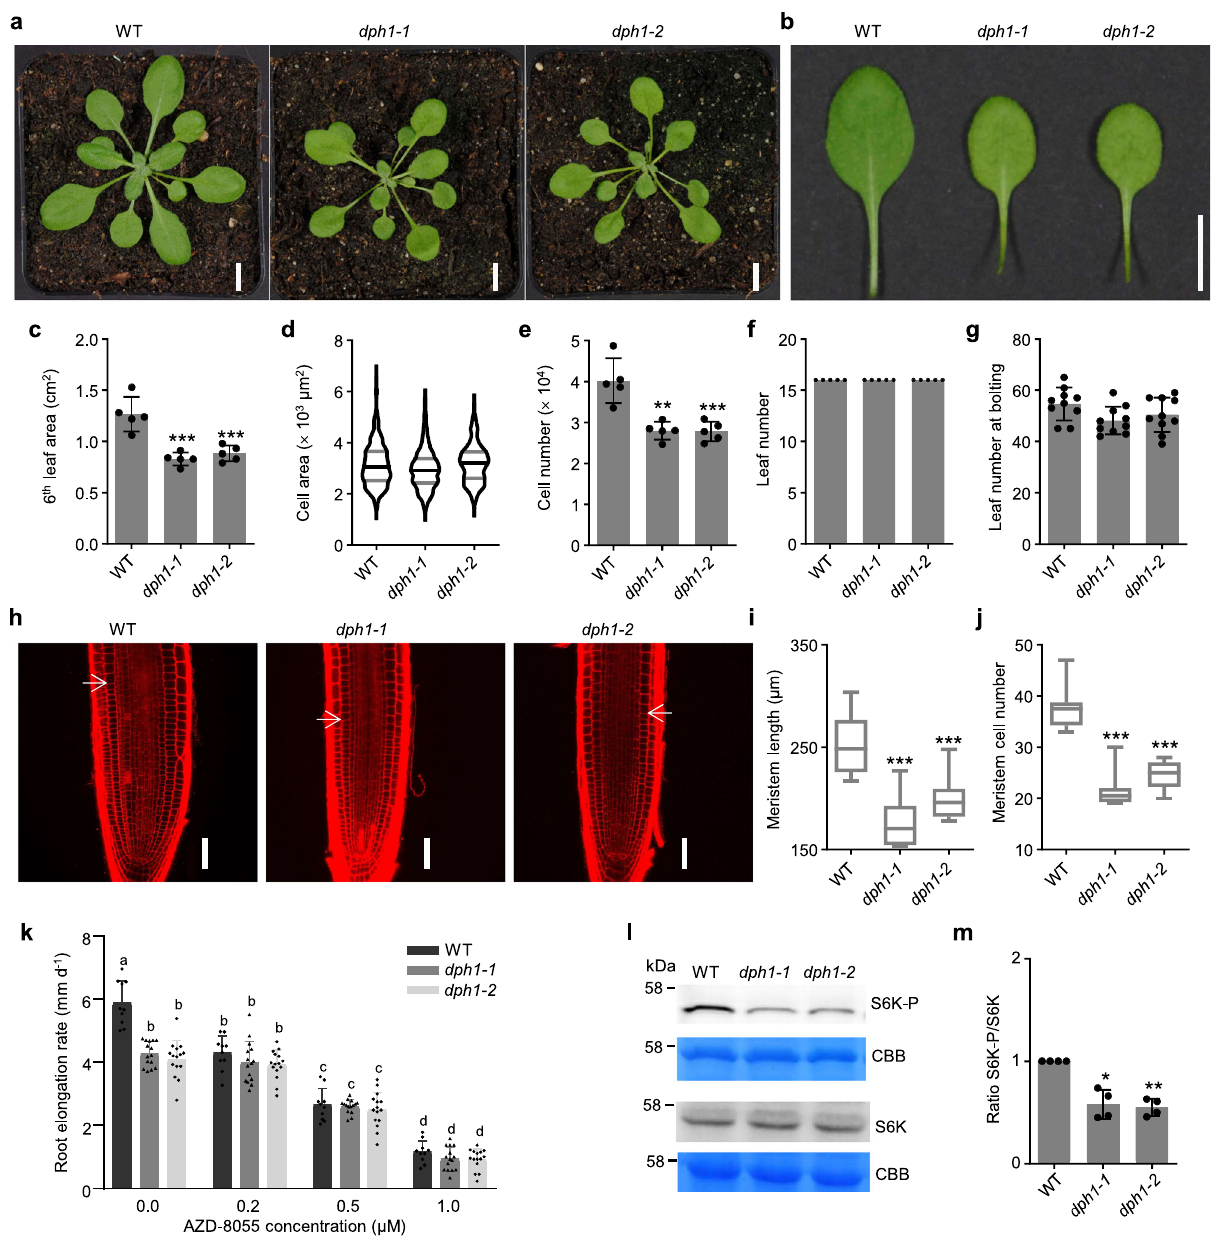
Fig. 3 Decreased organ size, cell number, and TOR activity in dph1 mutants. a Photographs of 4-week-old wild-type (WT) and dph1 plants cultivated in soil. b Sixth oldest leaves of the plants as shown in ( a ). Scale bars, 10 mm ( a , b ). c – e Leaf area ( c ), cell area ( d ), and cell number ( e ) of the sixth oldest leaves as shown in ( b ). f Number of leaves of plants as shown in ( a ). Data are mean ± s.d., n = 5 plants ( c , e , f ), and a boxplot, n = 272 (WT), n = 287 ( dph1- 1) , and n = 255 ( dph1-2) cells from a total of 5 plants ( d ). g Number of leaves at bolting. Data are mean ± s.d., n = 10 plants, with cultivation in neutral days (12 h light). h Confocal laser scanning microscopic images of PI-stained root meristematic zones of 9-day-old WT and dph1 mutant seedlings cultivated on 0.5× MS medium. Scale bars, 50 μ m. Arrows mark the cortex transition zones. i , j Meristem length ( i ) and meristem cell number ( j ) of roots as shown in h . Shown are boxplots, n = 12 seedlings per genotype. k Sensitivity to TOR kinase inhibitor. Data are mean ± s.d., n = 10 and 15 seedlings for WT and dph1 mutants, respectively, from day 4 to day 7 of AZD-8055 treatment (Supplementary Fig. 8). l , m TOR activity. Total protein extracts of 14-day-old seedlings grown in liquid 0.5× MS medium with 0.5% (w/v) sucrose were resolved by SDS-PAGE, blotted, and the membrane probed with antibodies against S6K-P and S6K or stained with Coomassie Brilliant Blue (CBB) as a loading control. m S6K-P/S6K ratio. Data are mean ± s.d., n = 4 independent experiments ( l and Supplementary Fig. 9). Violin/boxplots show median (center), 1st and 3rd quartile (gray lines/box), minimum and maximum (drawn lines/whiskers) ( d , i , j ). Signi fi cant differences from WT: * P < 0.05, ** P < 0.01, *** P < 0.001 (one-way ANOVA with Games-Howell test). Different characters re fl ect signi fi cant differences between means (two-way ANOVA, Scheffé test, P < 0.05, k ).